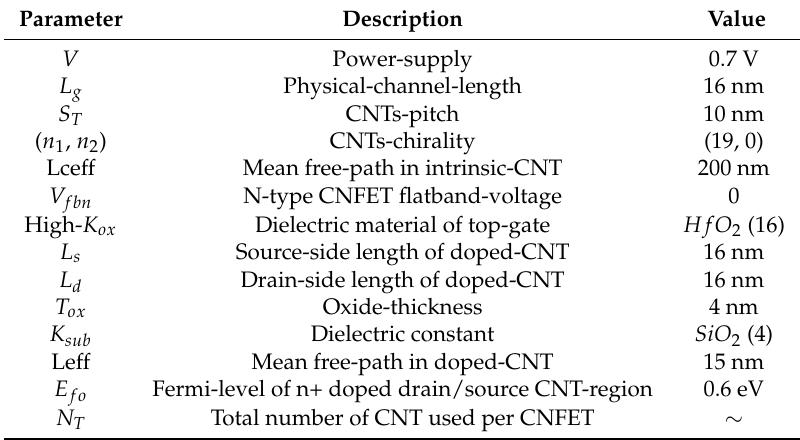
Table 1. The Stanford CNFET model